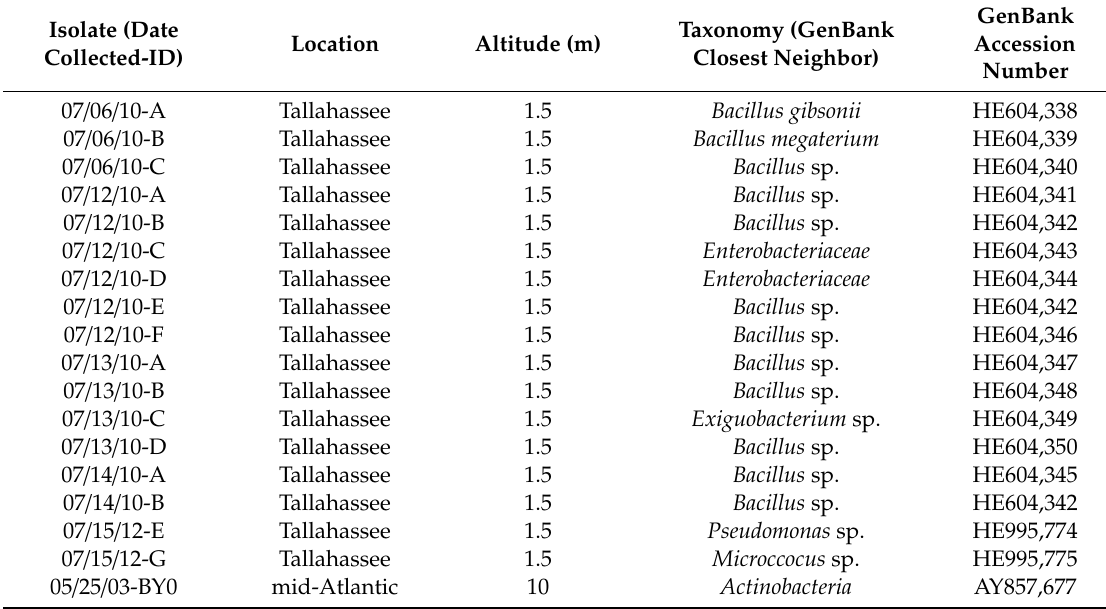
Table 1. Eubacteria isolate and sample site